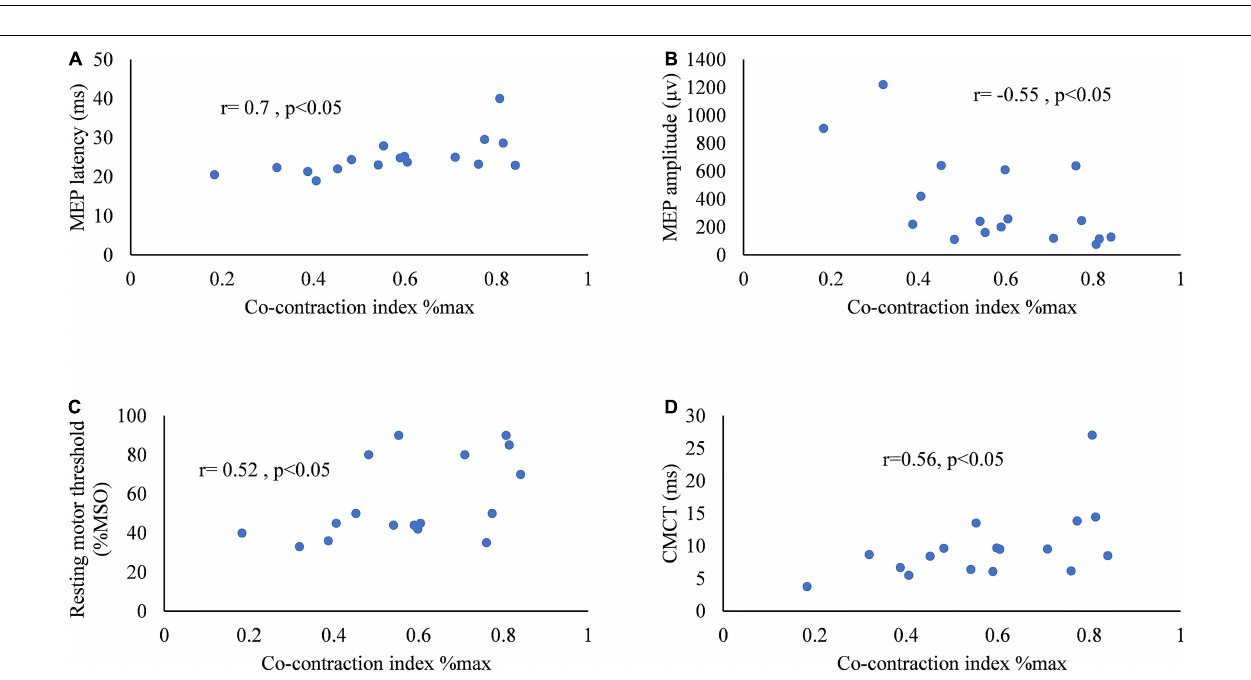
cortex (Groppa et al., 2012; Bestmann and Krakauer,